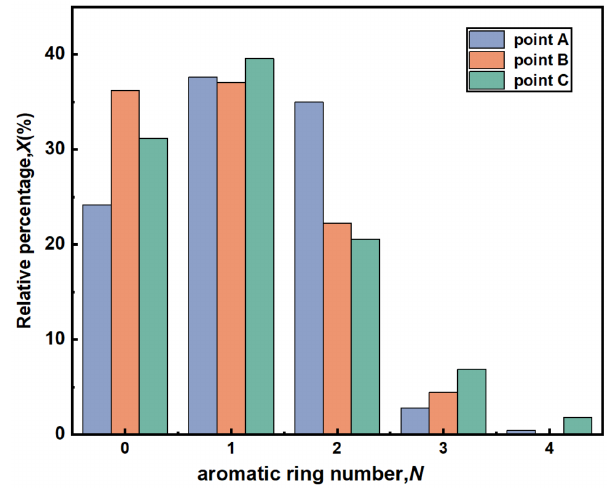
Figure 7. The number of aromatic rings in tar compounds.